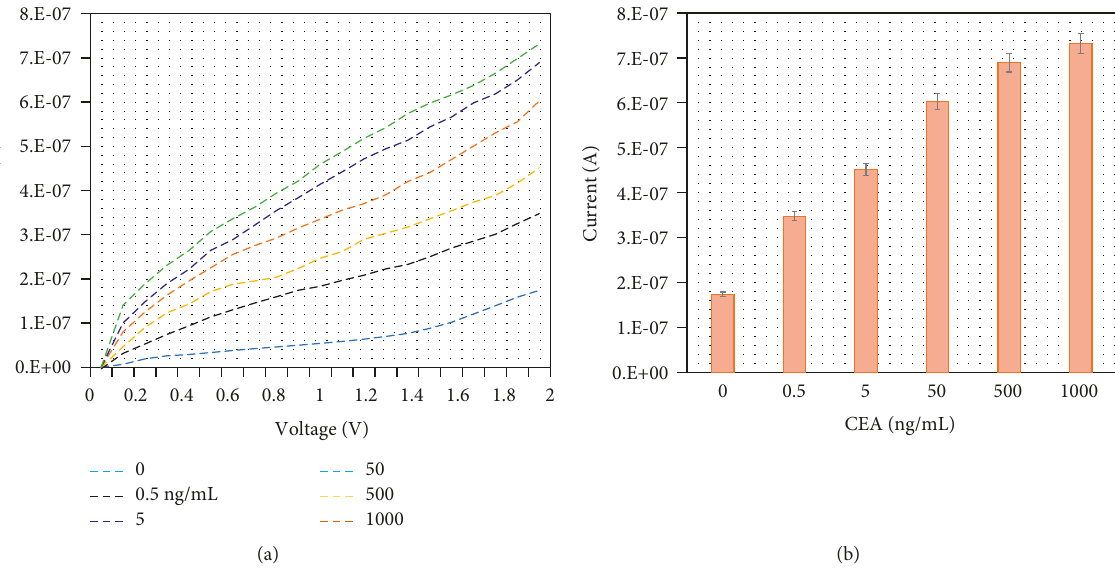
Figure 5: (a) CEA-spiked serum sample identification on the CNH-aptamer immobilized electrode surface. Various concentrations of CEA were diluted in serum and drop cast onto anti-CEA aptamer-constructed electrode surfaces for CEA identification. A clear increase in the response was recorded for each CEA concentration. (b) Electrochemical response for CEA-spiked serum identification. The electrochemical response was increased by increasing the CEA-spiked serum concentrations. The averaged values obtained from the replicates are displayed by the error